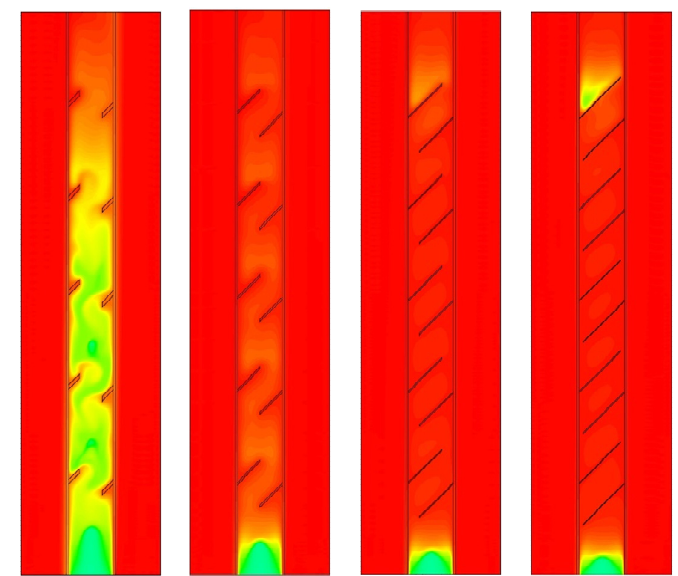
Figure 12. The temperature distribution in 1800 s in three time steps for different dimensions including case 3 (2 × 7.071 mm 2 ), case 3a (1 × 14.14 mm 2 ), case 3b (0.666 × 21.21 mm 2 ), and case 3c (0.55 × 25.76 mm 2 ).